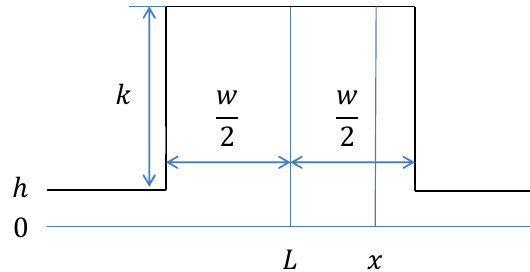
Figure 1. Line profile model used in this